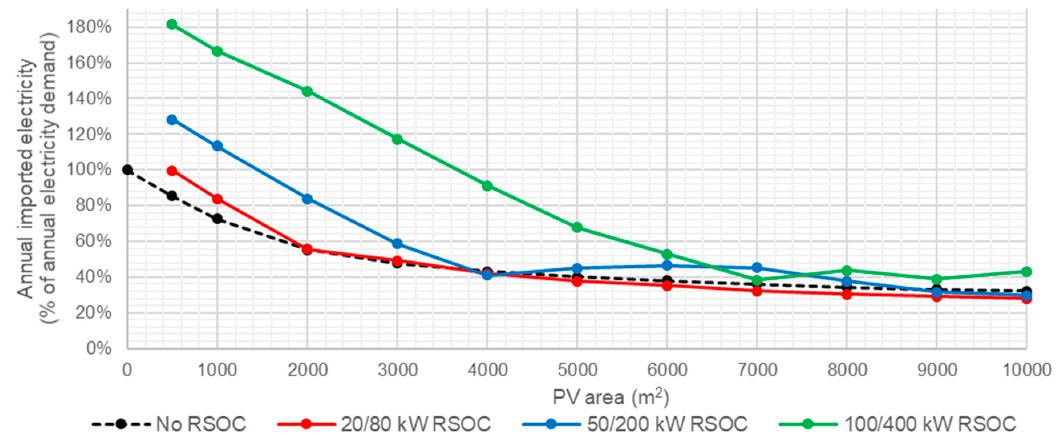
Figure 9. Annual imported electricity (for the optimal hydrogen storage size) as a function of installed solar PV panel area for the three RSOCHS systems and the reference system.